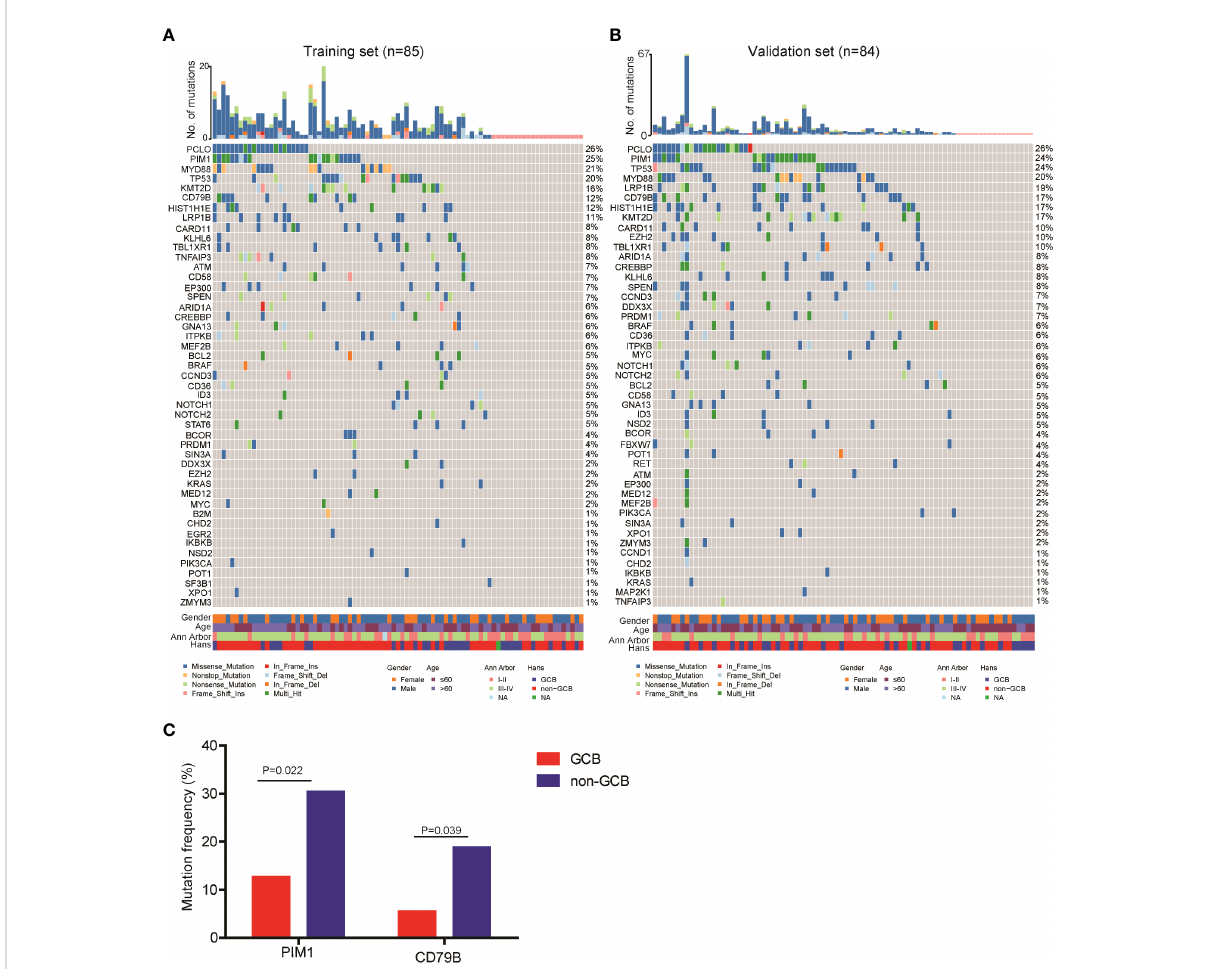
FIGURE 1 Mutation landscape of ctDNA samples from newly diagnosed DLBCL patients. ctDNA mutation pro fi les of newly diagnosed DLBCL patients in the (A) training and (B) validation sets. (C) The mutation frequencies of PIM1 and CD79B were signi fi cantly increased in the ctDNA samples of non-GCB DLBCL patients as compared with GCB DLBCL